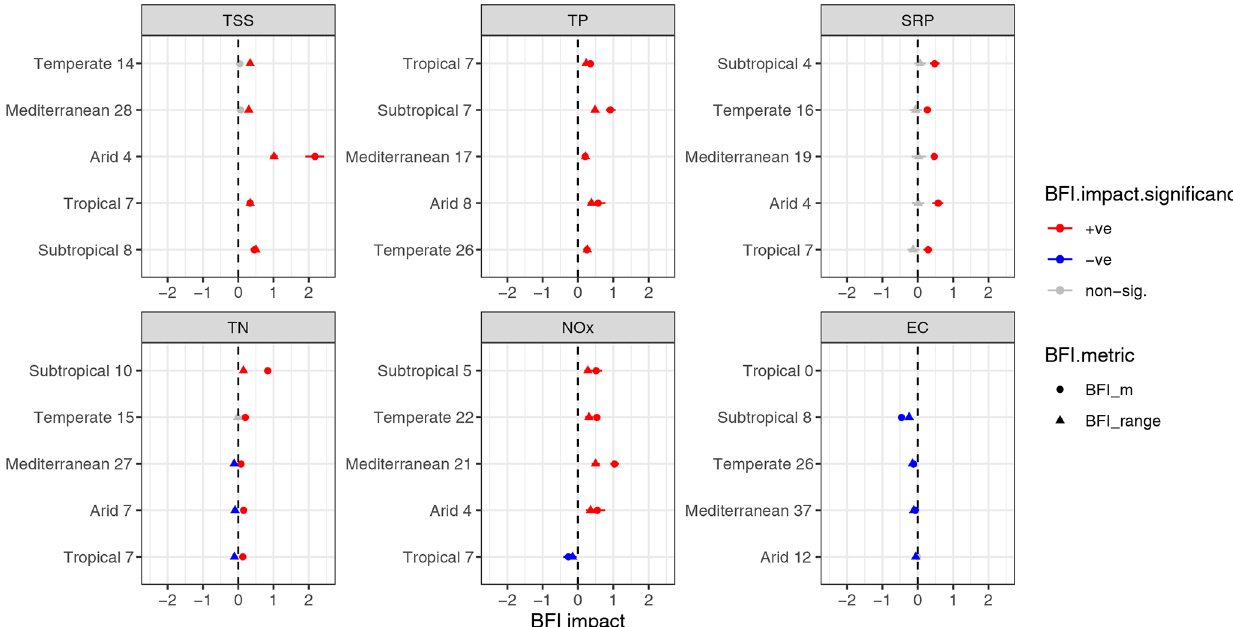
Figure 5. Modelled effects of BFI_m and BFI_range on catchment C – Q slopes for each climate zone ( δ BFI_climate ) for each water quality parameter. The bars show the 95% credible intervals (the range between 2.5th to 97.5th percentiles of Bayesian posterior distribution) of the modelled effects, and the dots indicate the corresponding median levels. The colours indicate whether an effect is significantly positive (red), significantly negative (blue) or non-significant (grey); a positive effect means that the C – Q slope increases with a higher catchment BFI_m or BFI_range, and vice versa. Dashed black lines show the zero effect, i.e. no effect at all. The plot includes results from models with each of BFI_m and BFI_range as the key predictor, which are differentiated by marker